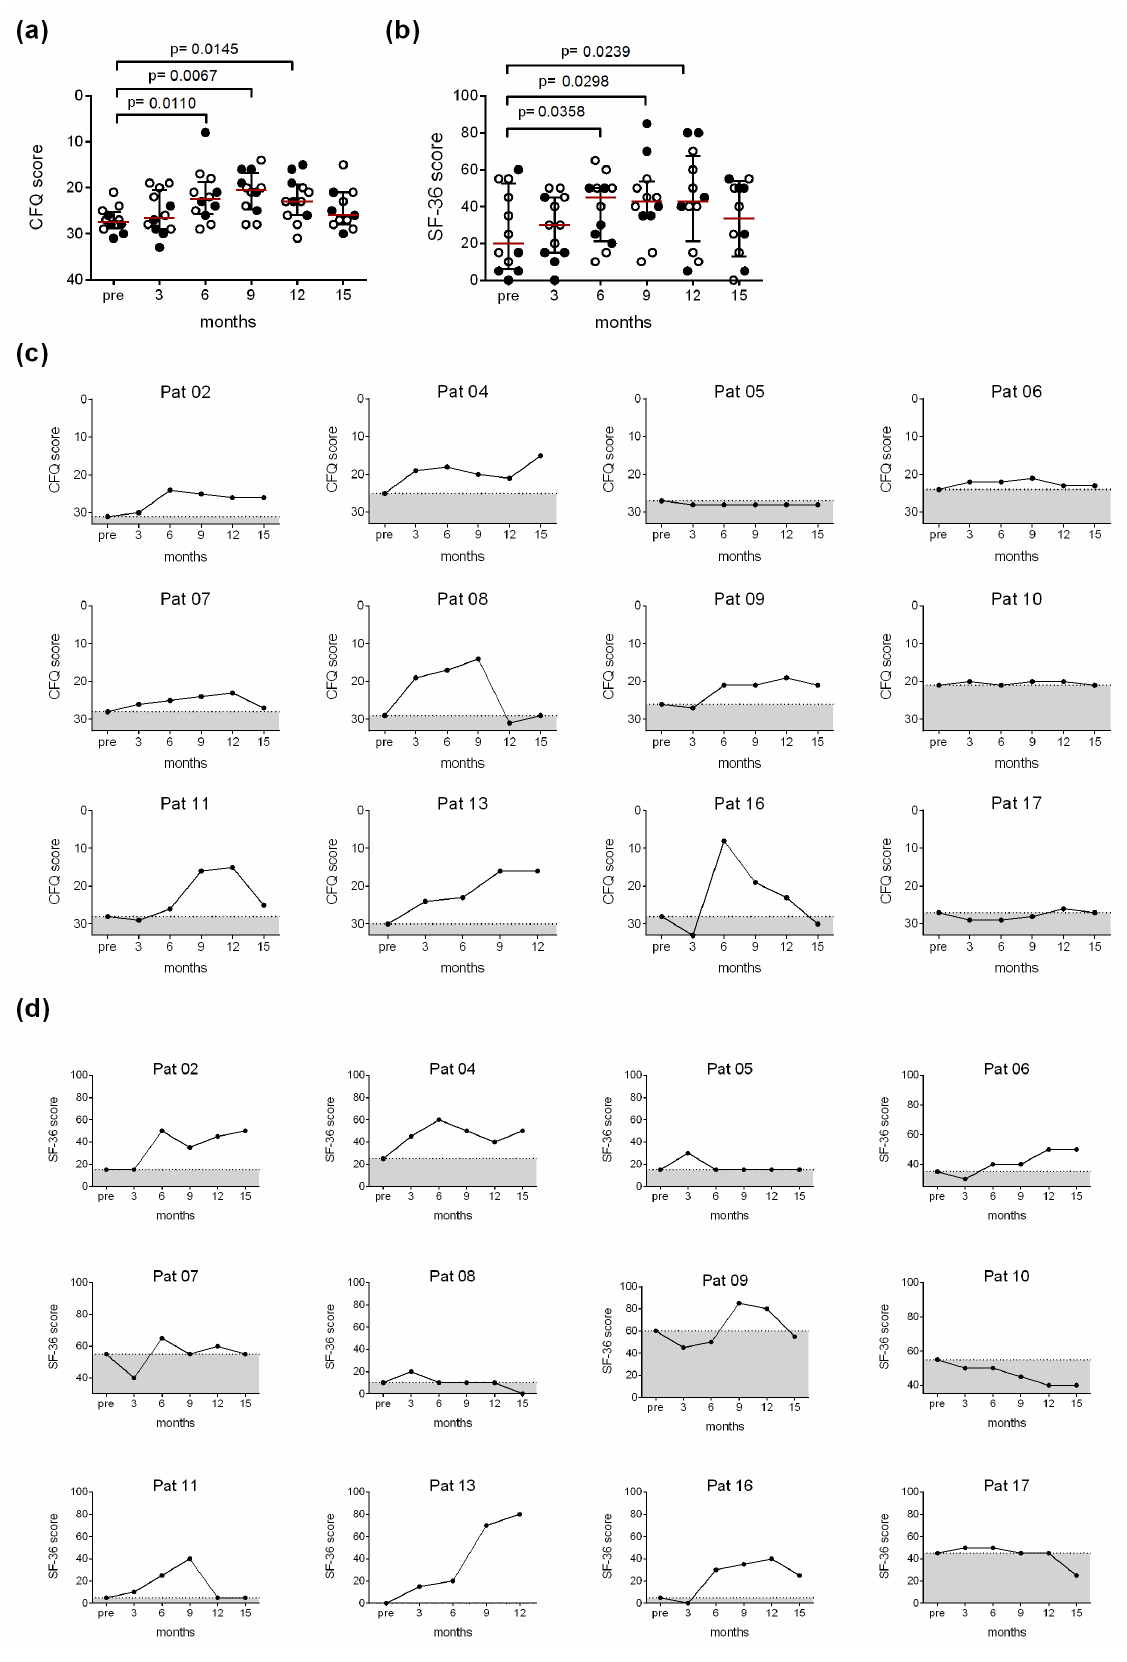
Figure 2. ( a ) The Chalder Fatigue Scale (CFQ) and the ( b ) SF-36 physical functioning of all patients receiving 12 months of treatment before (pre), during (months 3–12) and 3 months after the treatment (month 15) is shown. An overall significant